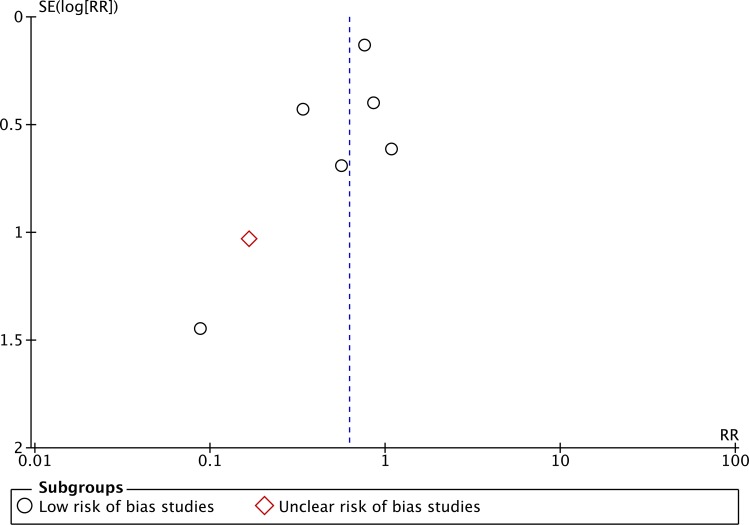
Funnel plot for outcome “Patient preferences for life-prolonging treatments”.